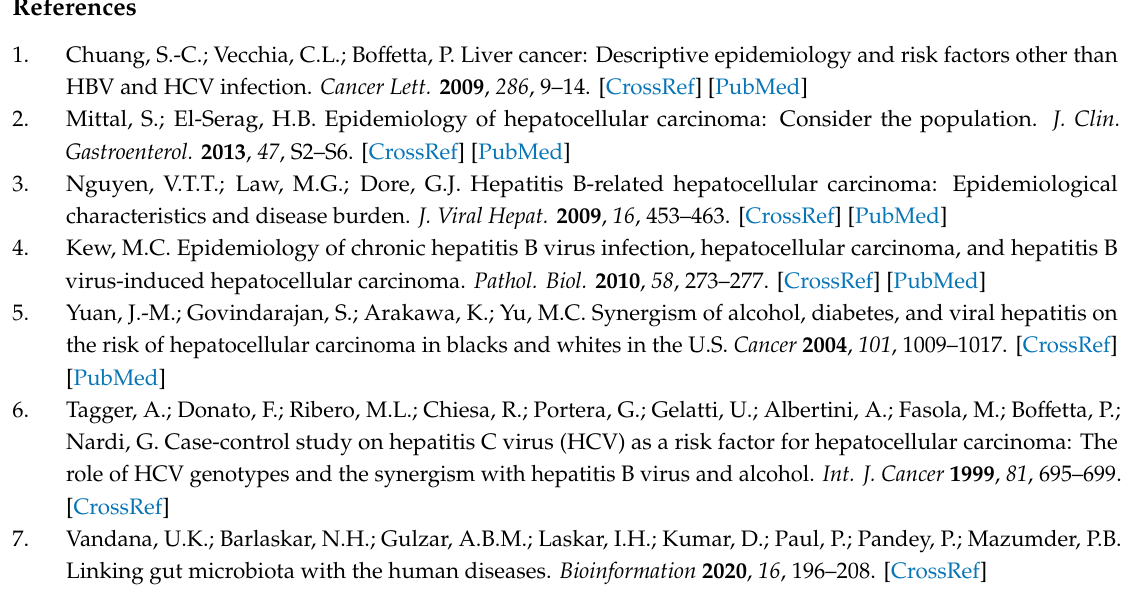
Figure S1: Kruskal Wallis Boxplots of Significant Correlations between Clinical Variables and Microbial